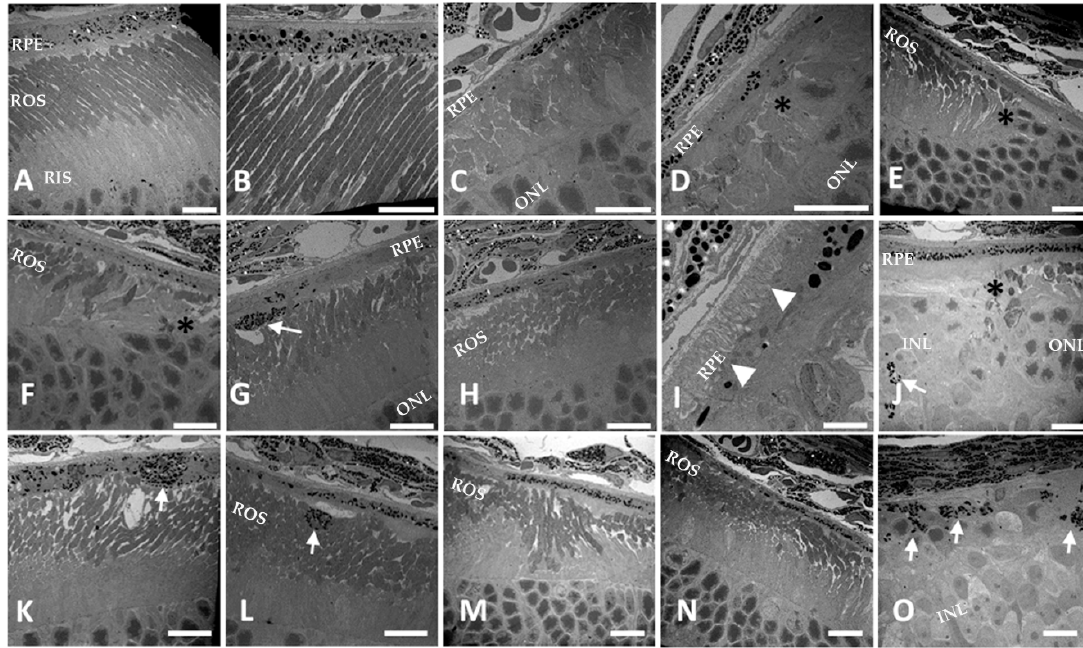
Figure 6. High magnification observation of Dhdds flx/flx CreRPE retina. EM images of 3m ( A , B ) Dhdds flx/flx and ( C – O ) Dhdds flx/flx CreRPE mice. Mice homozygous for the floxed Dhdds allele ( Dhdds flx/flx